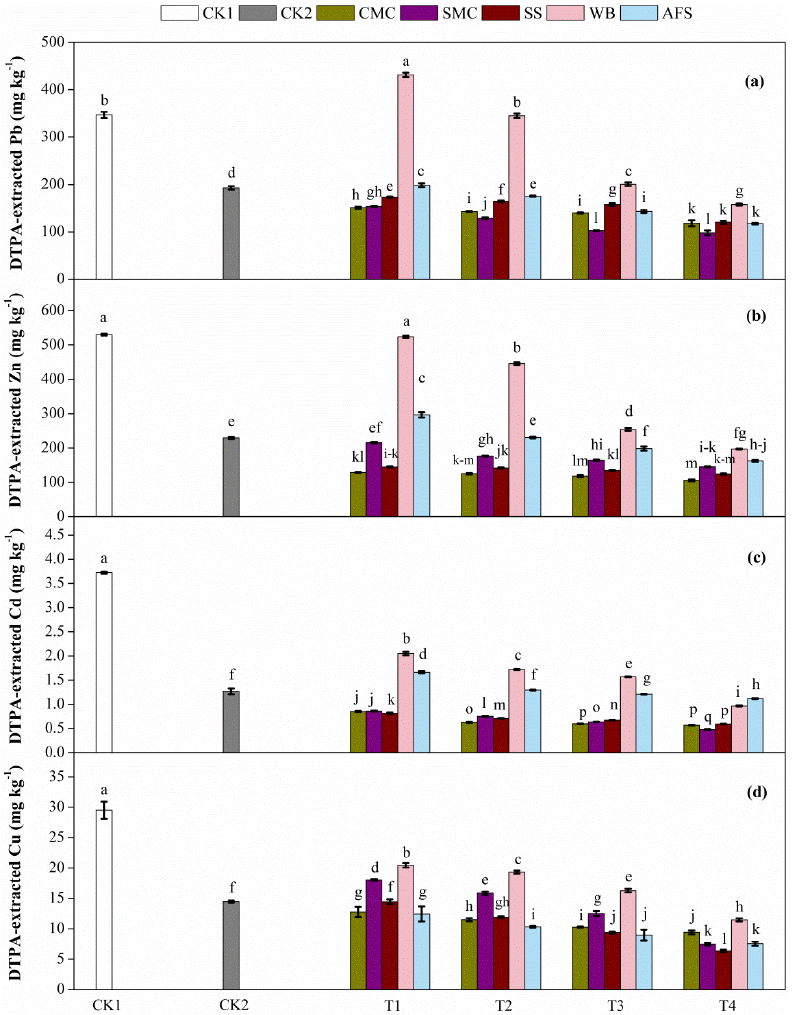
Figure 1. E ff ect of amendments on DTPA-extractable Pb ( a ), Zn ( b ), Cd ( c ) and Cu ( d ) in treated tailings. CK1 = Only tailings and CK2 = Tailings plus TSP. The amendment treatments are denoted as T1, T2, T3 and T4. Error bars represent the standard deviation of the mean ( n = 3). Letters above the bars refer to the di ff erence at significance level ( p < 0.05, LSD) among di ff erent treatments. CK1: Control 1; CK2: Control 2; CMC: Cattle manure compost; SMC: Spent mushroom compost; SS: Sewage sludge; WB: Wood biochar; AFS: Agricultural field soil; DTPA: Diethylenetriaminepentaacetic acid (for interpretation of the references to color in this figure legend, the reader is referred to the web version of this